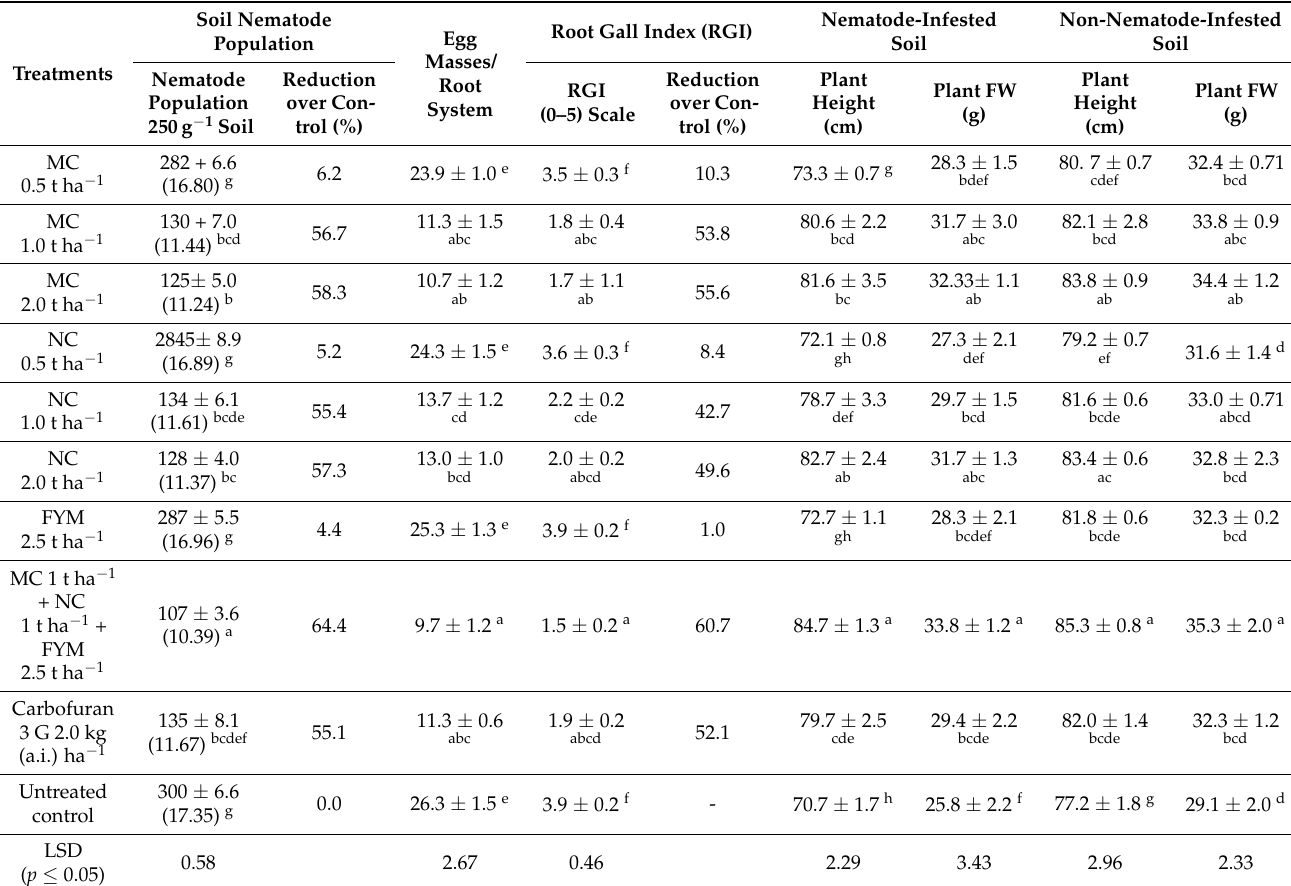
Table 2. Effects of different soil amendments on root-knot nematode infestations and plant growth parameters of cucumbers grown in